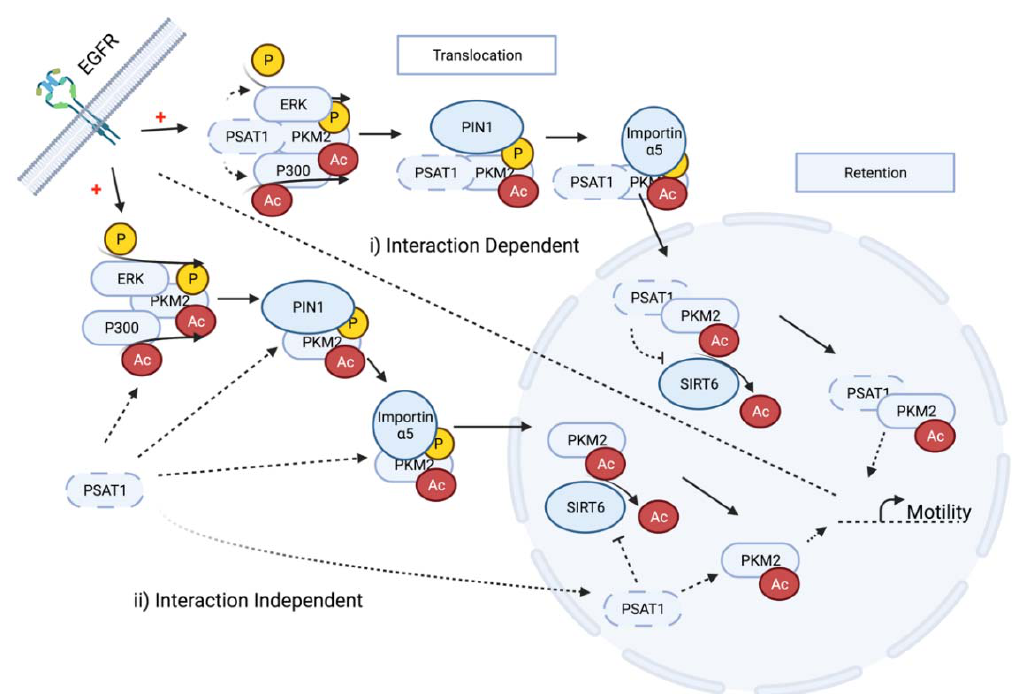
Figure 8. Schematic depicting putative nodes for PSAT1 regulation in the nuclear translocation and retention of PKM2 in response to EGFR activation. ( i ) PSAT1 interaction may promote cytoplasmic PKM2 phosphorylation and acetylation or suppress nuclear SIRT6-dependent deacetylation that contributes to nuclear PKM2 function in increasing pro-motility gene expression. ( ii ) PSAT1 may influence various steps involved in PKM2’s translocation and retention independent of direct PKM2 interaction. Dotted lines indicate putative PSAT1 regulatory